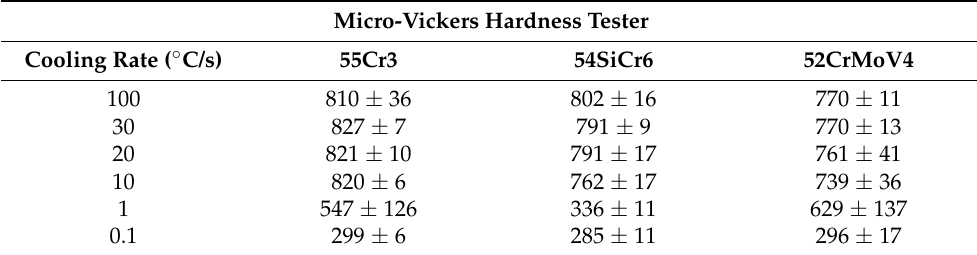
Table 4. Hardness measurements determined at various cooling rates.